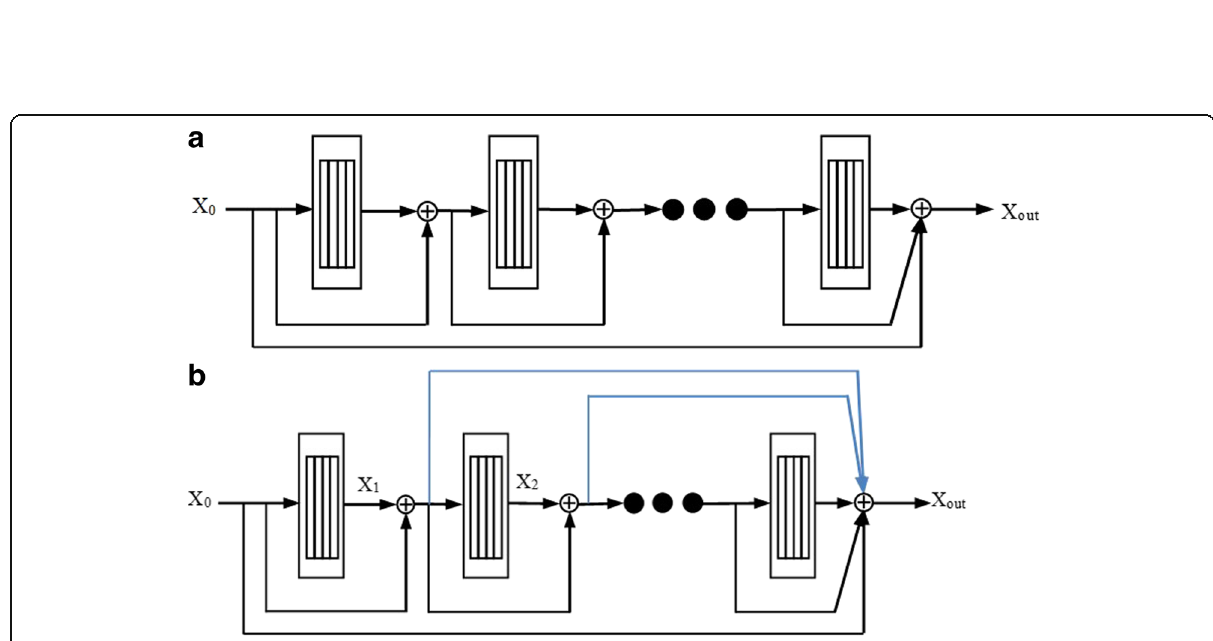
Fig. 4 The original residual network and the improved residual